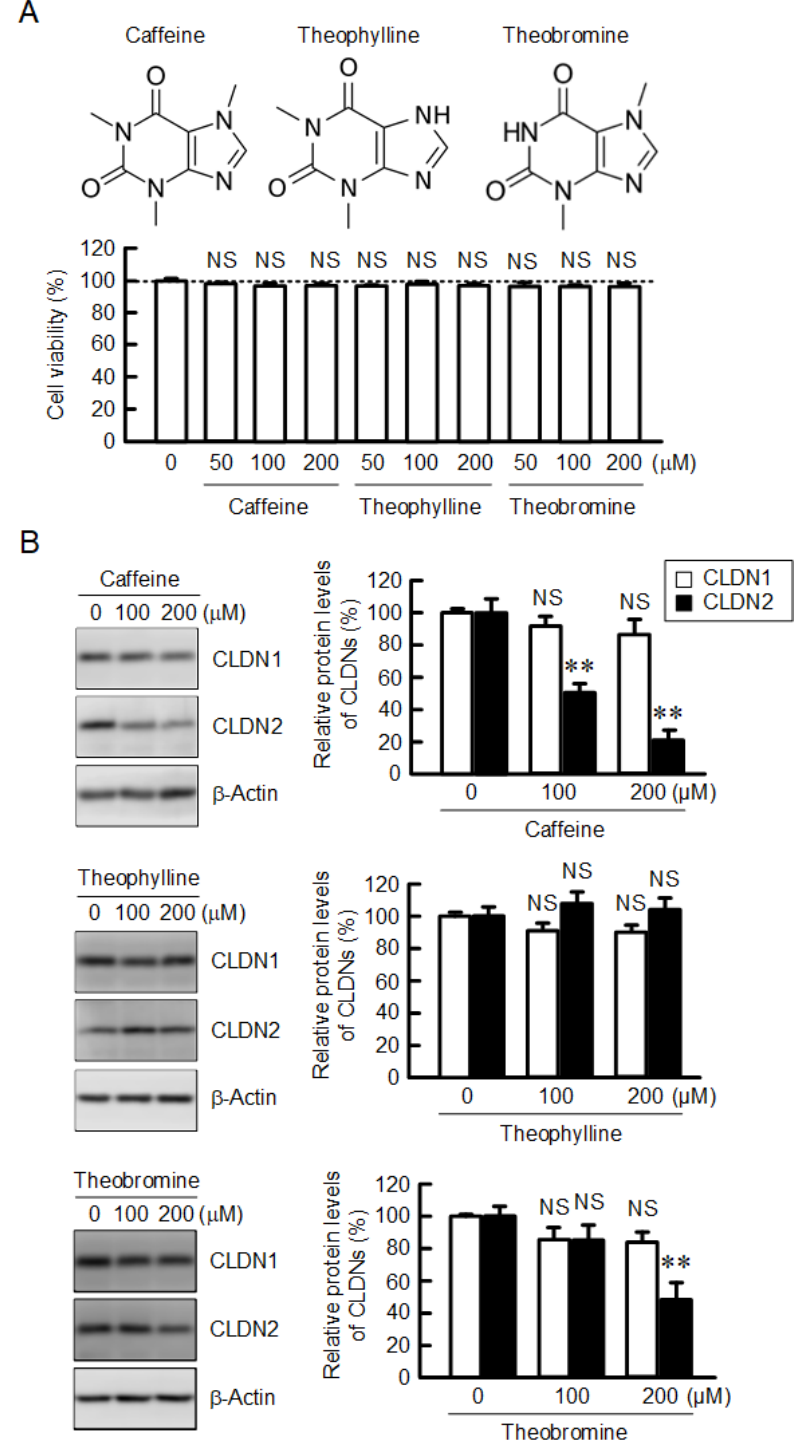
Figure 1. Effects of methylxanthine derivatives on cell viability and CLDN expression in A549 cells. ( A ) The structures of caffeine, theophylline, and theobromine are shown in the upper panel. Cells were incubated with caffeine, theophylline, or theobromine at the indicated concentrations for 24 h, followed by incubation with CCK-8 reagent. Cell viability is represented as a percentage relative to 0 µ M. ( B ) The expression levels of CLDN1, CLDN2, and β -actin were examined by Western blotting. The protein levels of CLDN1 and CLDN2 are represented as a percentage relative to 0 µ M. n = 4–7. ** p < 0.01 and NS p > 0.05 compared with 0 µ